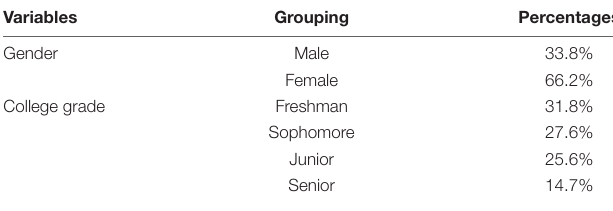
TABLE 1 | Background variable